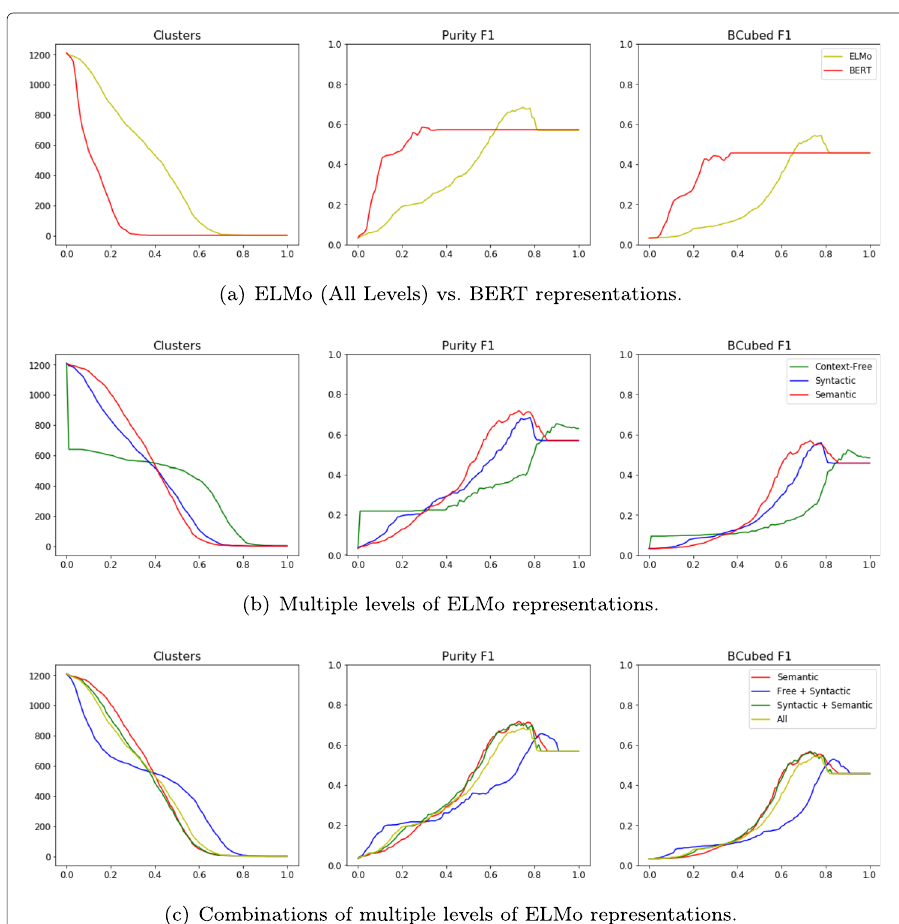
Fig. 6 Semantic role induction results achieved using different contextualized representations of verb arguments. The horizontal axes refer to the neighboring threshold used to create the edges